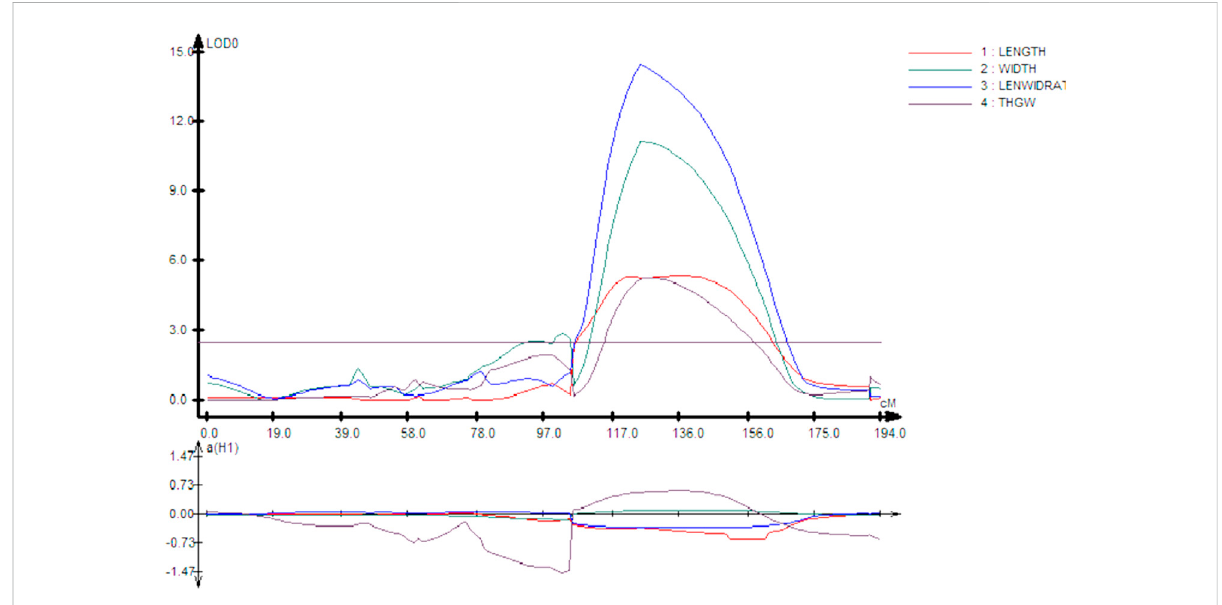
FIGURE 2 LOD and additive effect of QTLs on chromosome 8 of all four